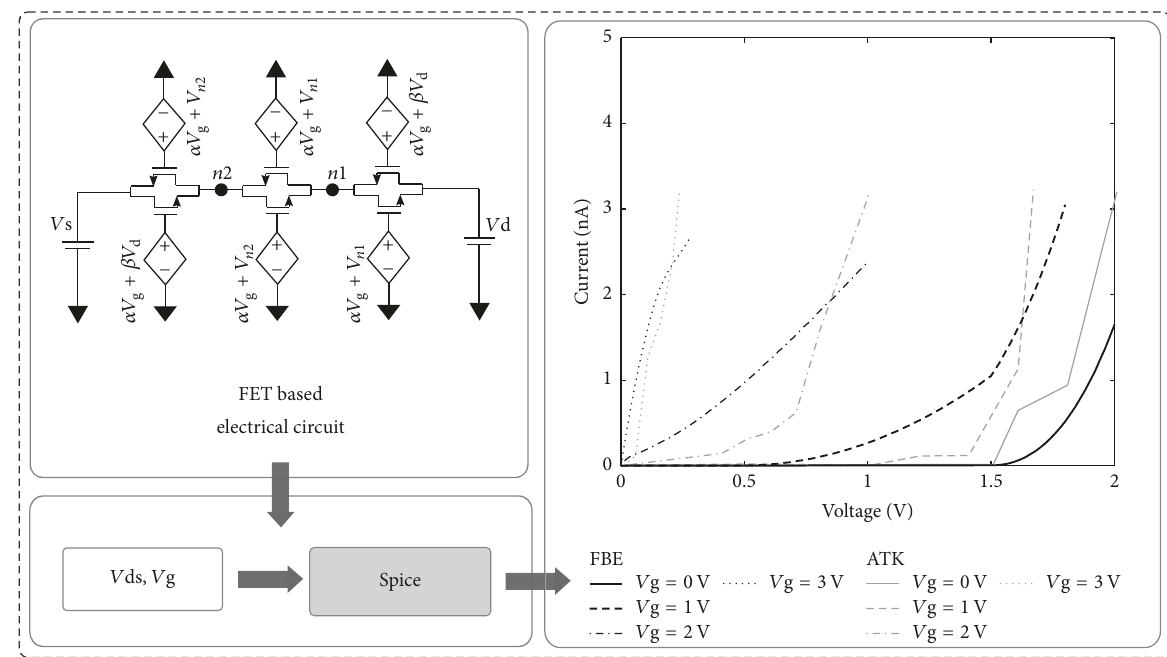
Figure 6: Electrical equivalent model (FBE): based on level 1 FET spice model. The phenyl ring with ethylene chain connected to it is modeled = 0.1 )becauseofdelocalizedpi-bondsandM2transistor(with 𝑉 withM1transistor(with 𝑉 th bonds. Two parallel NFETs are used to model the effect of potential of neighboring atoms. Corresponding IV characteristics for different gate voltages are shown on the right (black lines: FBE; grey lines: ATK).